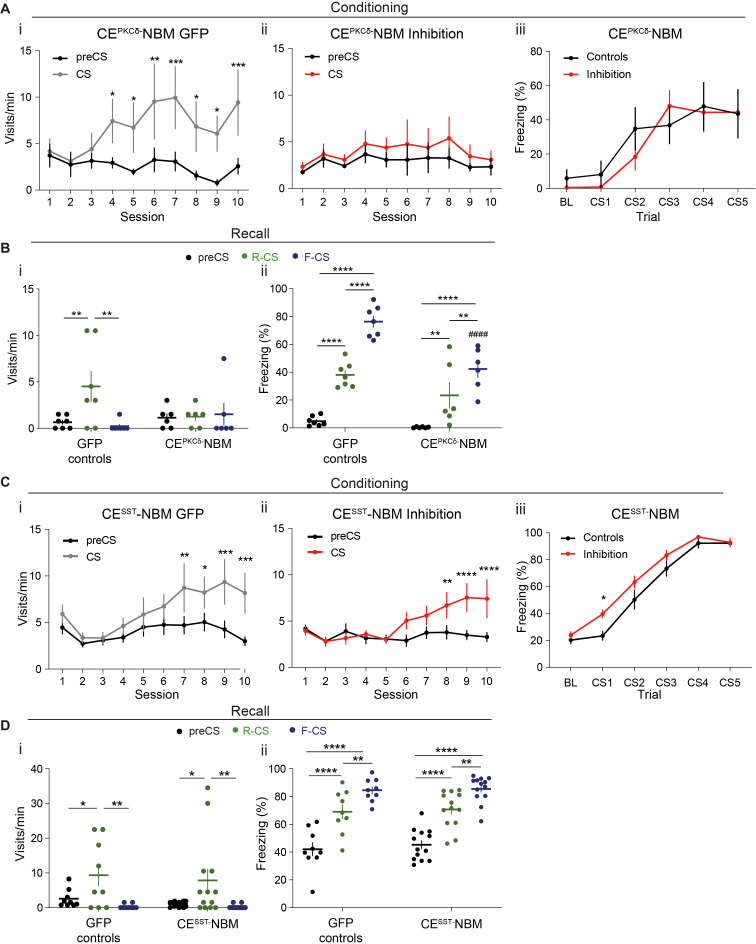
A cell-type-specific CE–NBM pathway is required for Pavlovian learning.(A) Learning curves of approach behavior of the CEPKCδ-NBM cohort in (i) controls (significant CS x session interaction in a two-way RM ANOVA, F9,54=2.54, p=0.0163) and (ii) the CEPKCδ-NBM inhibition group (no significant effect in a two-way RM ANOVA). (iii) Learning curves for avoidance behavior in the control and CEPKCδ-NBM inhibition group during the FC stage (significant effect of trial in a two-way RM ANOVA, F5,60=15.37, p<0.0001). (B) Quantification of CS-specific (i) approach (visits/min)(significant CS x treatment interaction in a two-way RM ANOVA, F2,22=3.97, p=0.0338) and (ii) avoidance behavior (percent time spent freezing) (significant CS x treatment interaction in a two-way RM ANOVA, F2,22=3.11, p=0.0095) at the recall session. ##p<0.01 (compared to control group), **/##p<0.01, ****p<0.0001; nGFP = 7, nCE-PKCδ–NBM=6, Data presented as mean ± SEM. (C) Learning curves of approach behavior for the CESST-NBM cohort in (i) controls (significant CS x session interaction in a two-way RM ANOVA, F9,72=2.63, p=0.0109) and (ii) the CESST-NBM inhibition group (significant CS x session interaction in a two-way RM ANOVA, F9,108=4.75, p<0.0001). (iii) Learning curves for avoidance behavior of the control and CESST-NBM inhibition groups during the FC stage (significant effect of treatment in a two-way RM ANOVA, F1,20=10.70, p=0.0038). (D) Quantification of CS-specific (i) approach (significant effect of CS in a two-way RM ANOVA, F2,40=11.59, p=0.0001) and (ii) avoidance behavior (significant effect of CS in a two-way RM ANOVA, F2,40=77.68, p<0.0001) at recall for the CESST-NBM cohort. Holm-Sidak post hoc for all analyses, *p<0.05, **p<0.01, ***p<0.001, ****p<0.0001. nGFP = 9, nCE-SST–NBM=13. All data presented as mean ± SEM. Full statistical report in Appendix 1—table 1.